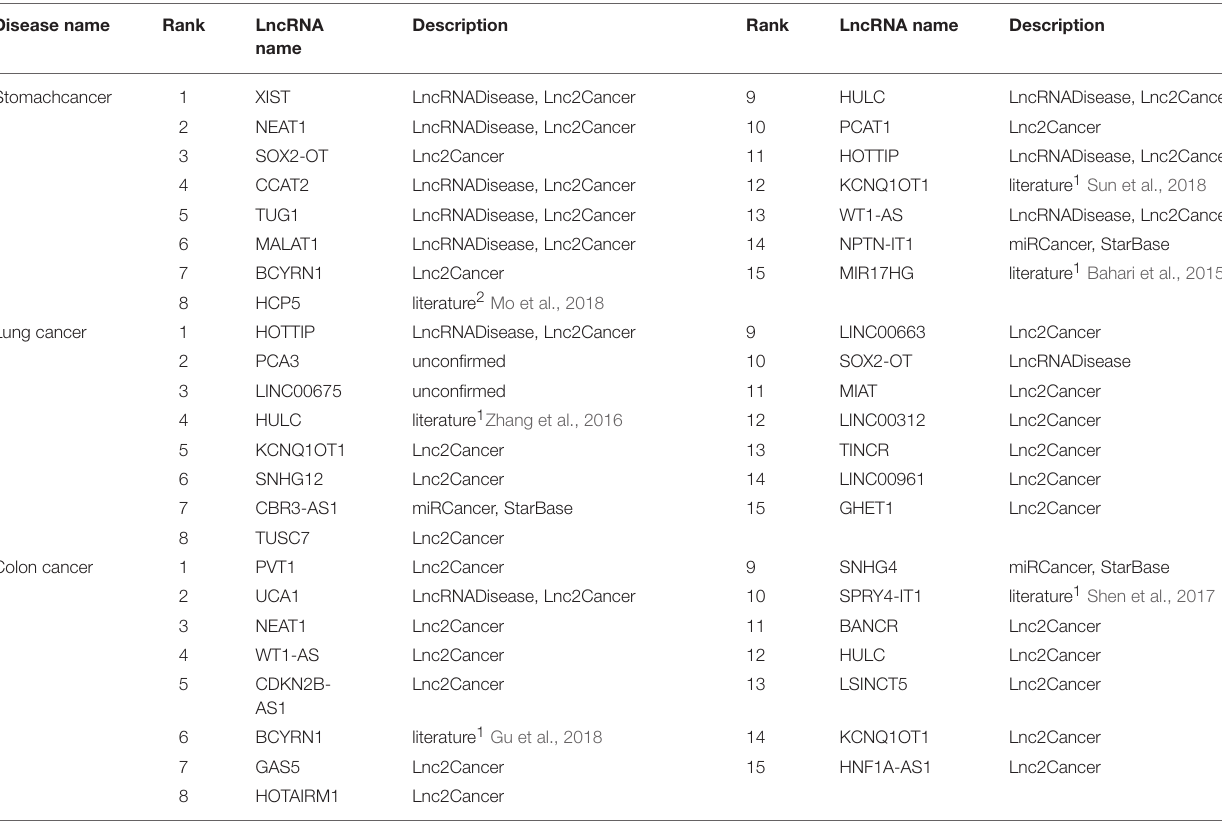
TABLE 4 | The candidate lncRNAs associated with stomach cancer, lung cancer and colon cancer. Disease